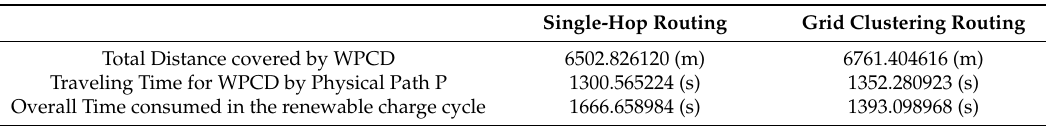
Table 4. Entire simulation results for a wireless rechargeable network.